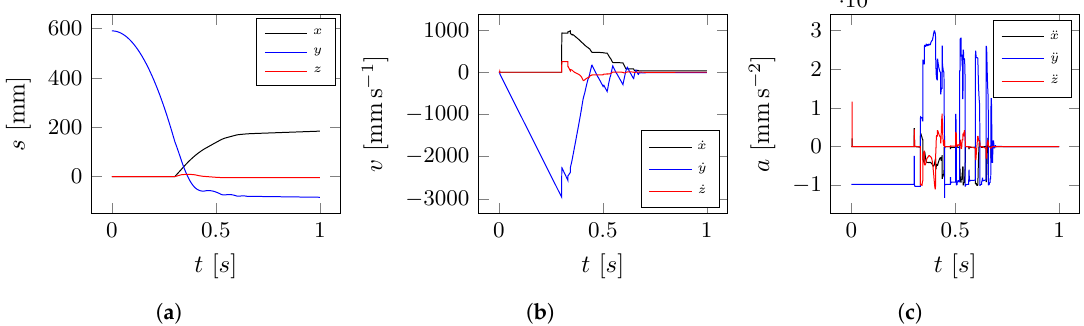
Figure 11. Information about the state of the lander’s MBS along the vertical axis: ( a ) the displacement of the center of mass; ( b ) the velocity; ( c ) the acceleration.